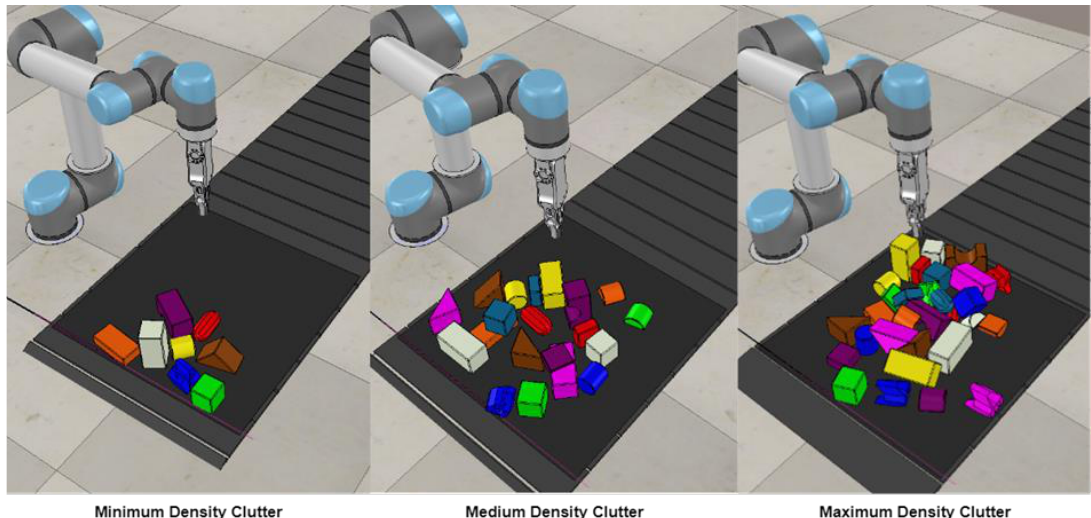
Figure 16. Three categories based on clutter densities.